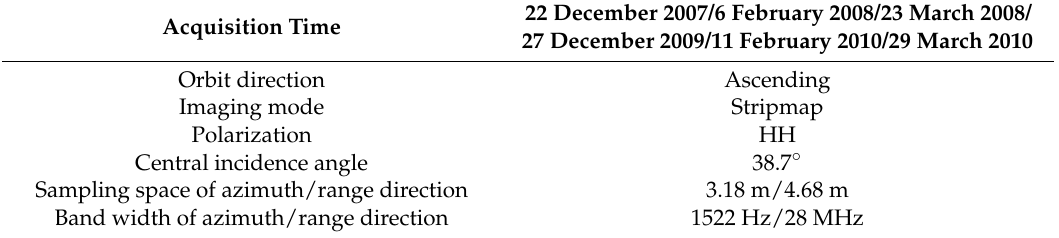
Table 5. Image parameters for ALOS/PLASAR data.